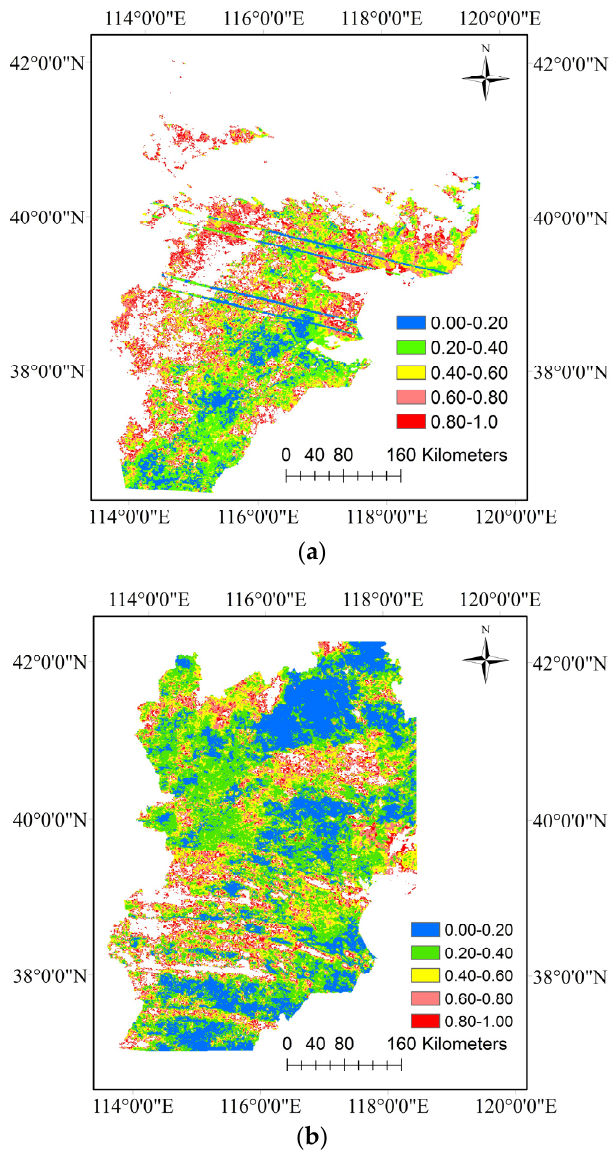
Figure 9. The AOD spatial distribution over the Beijing–Tianjin–Hebei region. ( a ) The inversion image was acquired on 10 February 2015, and the reference image (the ‘clear day’) was acquired on 8 February 2015. In this inversion progress, d is set to 100. ( b ) The inversion image was acquired on 14 February 2015, and the reference image was acquired on 10 February 2015. In this inversion progress, d is set to 225. τ ( t 1 ) is assumed to